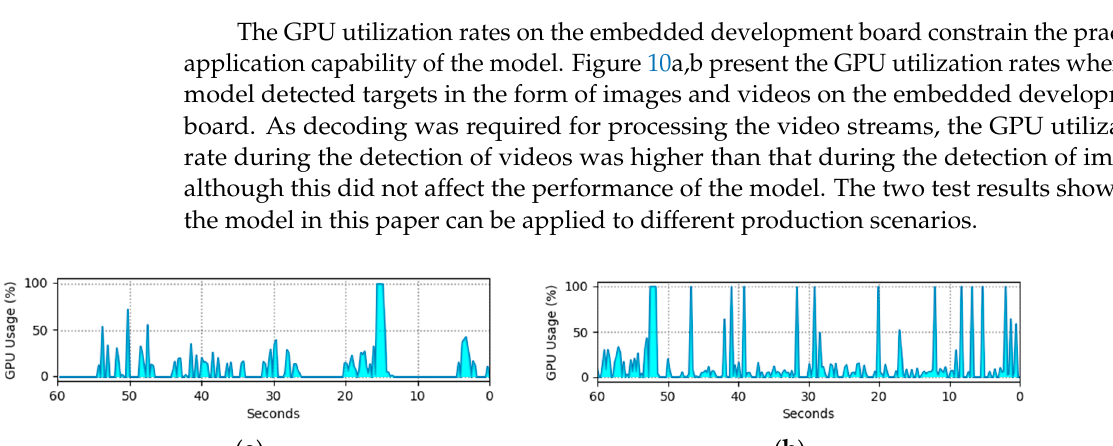
Table 3. Model test effect comparison.